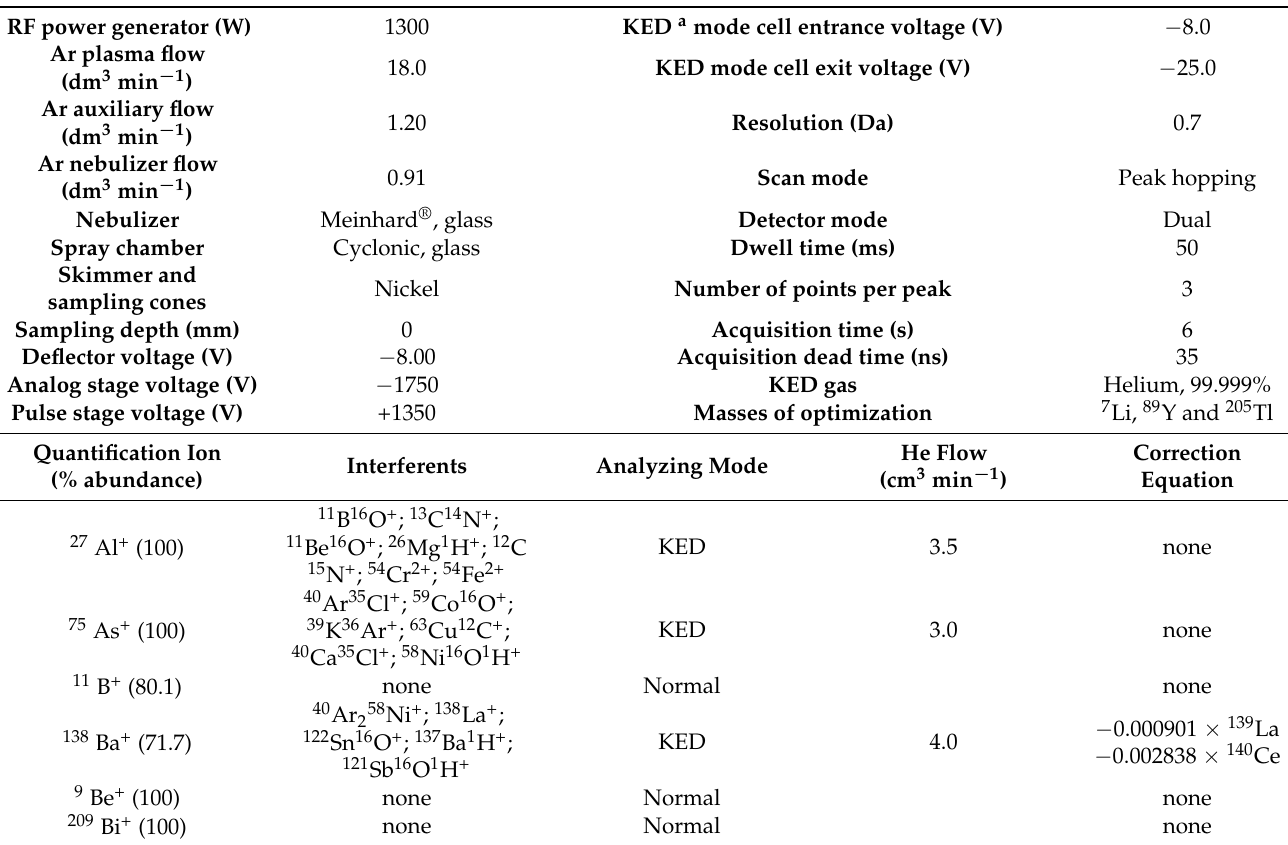
Table 1. Instrumental parameters and elemental settings used for the ICP-MS determination of 23 toxic elements and oligoelements in